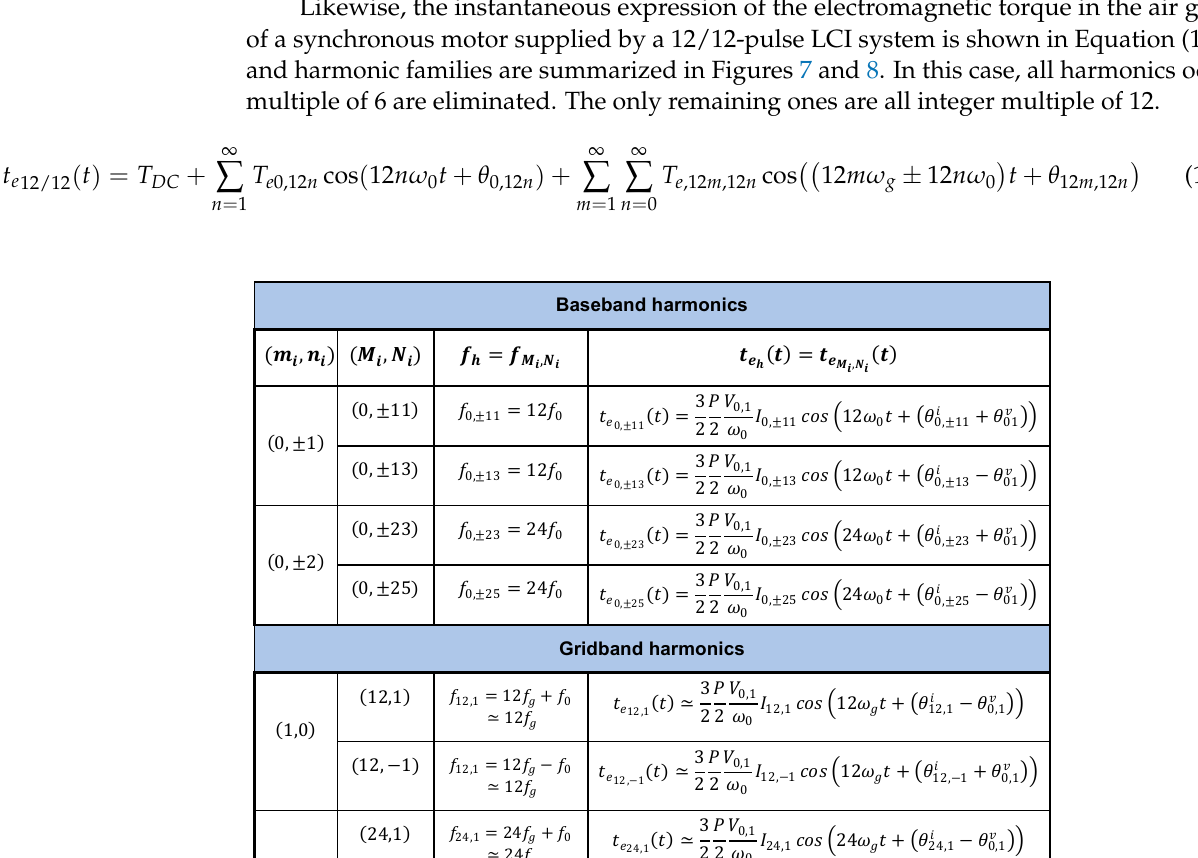
Figure 7. Harmonic families in a 12/12-pulse LCI system: baseband and gridband families.